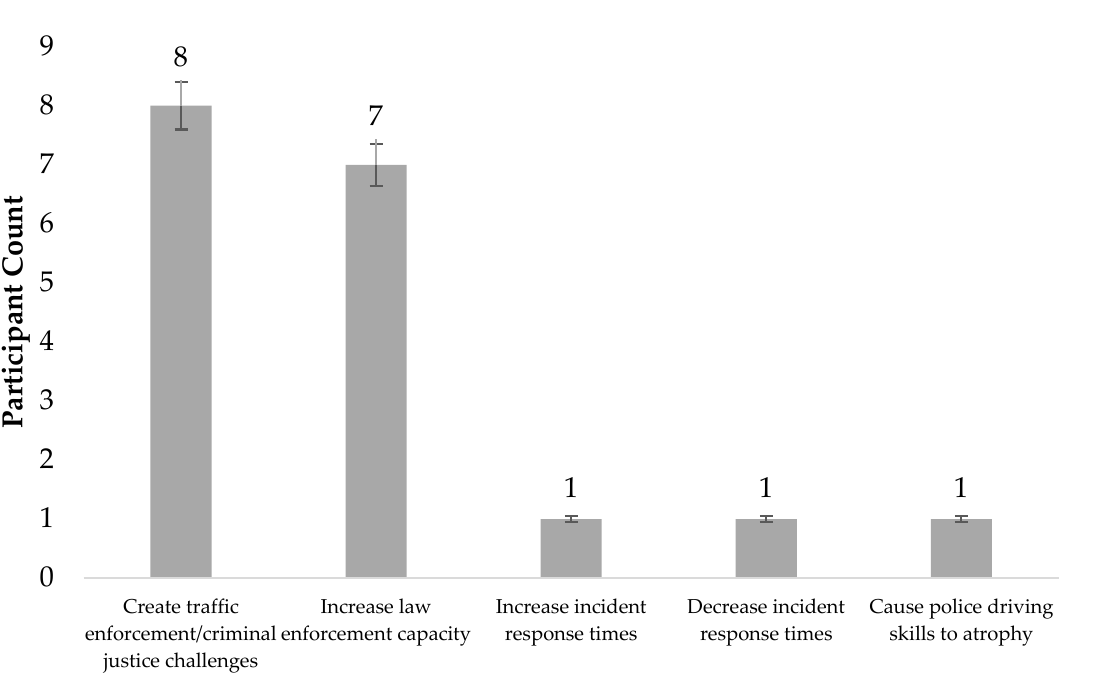
Figure 4. Self-driving technology implications for policing.